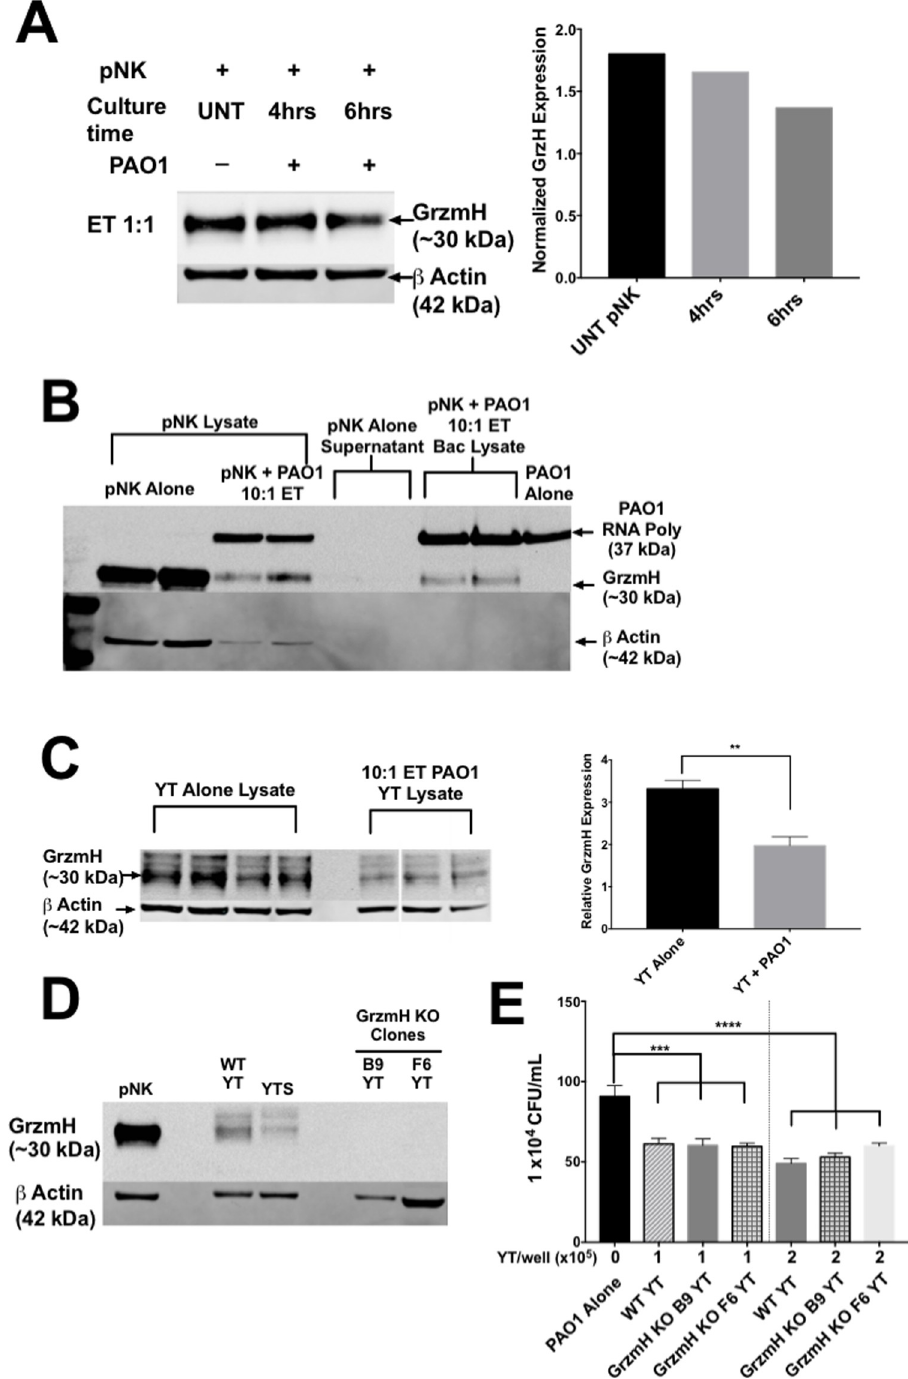
Fig 8. Single KO of GrzmH does not affect YT cell killing of PAO1. (A) Western blot and densitometry of pNK cells (1x10 6 cells), alone or co-cultured with 1x10 6 cells bacteria for either 4 or 6 h. Blotted using (1:1000) mouse antibodies specific for human GrzmH. Rabbit antibody specific for human beta actin antibody was used as a loading control. Intracellular GrzmH levels were normalized to beta actin for densitometry. (B) Western blot analysis of pNK cells (1x10 6 cells), alone or co-cultured with 1x10 5 PAO1 for 6 h. PAO1 was isolated from the co-culture using a series of centrifugation and washes with sterile distilled water to form a bacterial pellet which was lysed with 2x Sample Buffer and then boiled. Blotted using (1:1000) mouse antibodies specific for human GrzmH. Rabbit antibody specific for human beta actin and a rabbit antibody specific was E . coli RNA polymerase were used as loading controls for the pNK